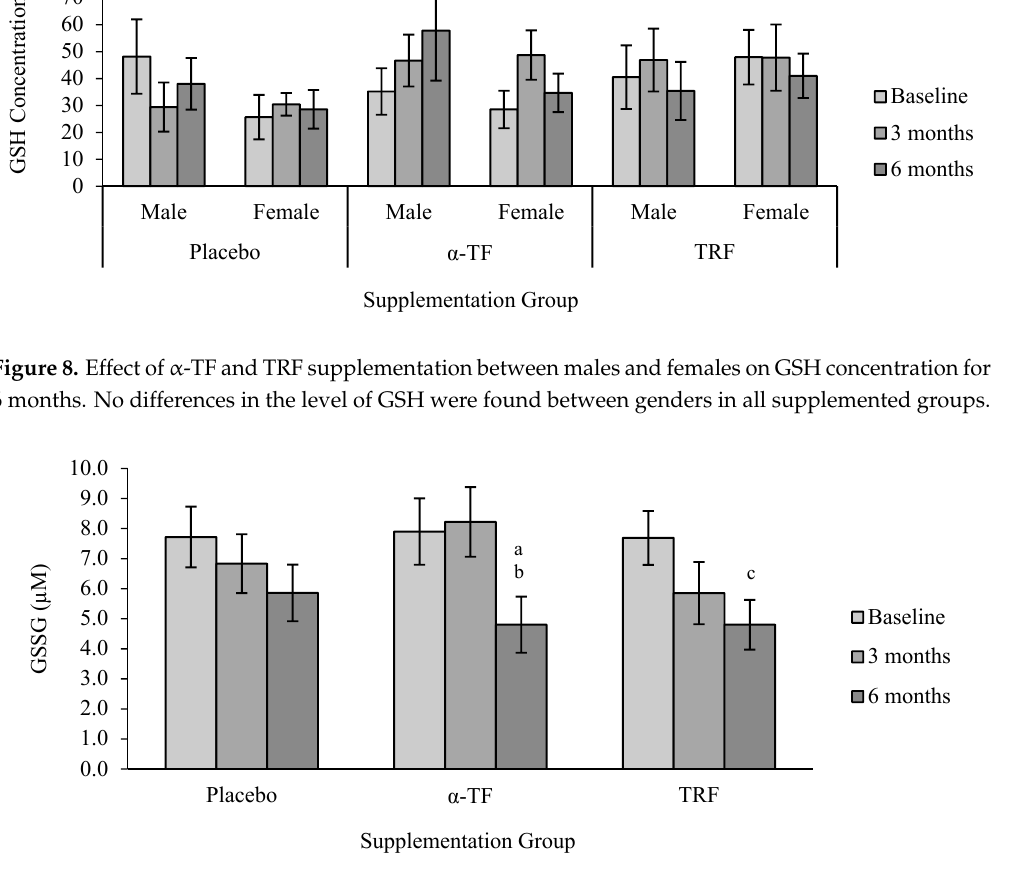
Figure 10. Effect of α -TF and TRF supplementation between males and females on GSSG concentration for 6 months. a = significantly different compared to 3-month α -TF (male), p < 0.05. The ratio of GSH/GSSG increased after 6 months of TRF and α -TF supplementation (Figure 11). These effects were seen only in female subjects with both supplementations (Figure 12). Figure 11. Effect of α -TF and TRF supplementation on GSH/GSSG ratio for 6 months. a = significantly different compared to 0-month α -TF, b = significantly different compared to 0-month TRF, p < 0.05.